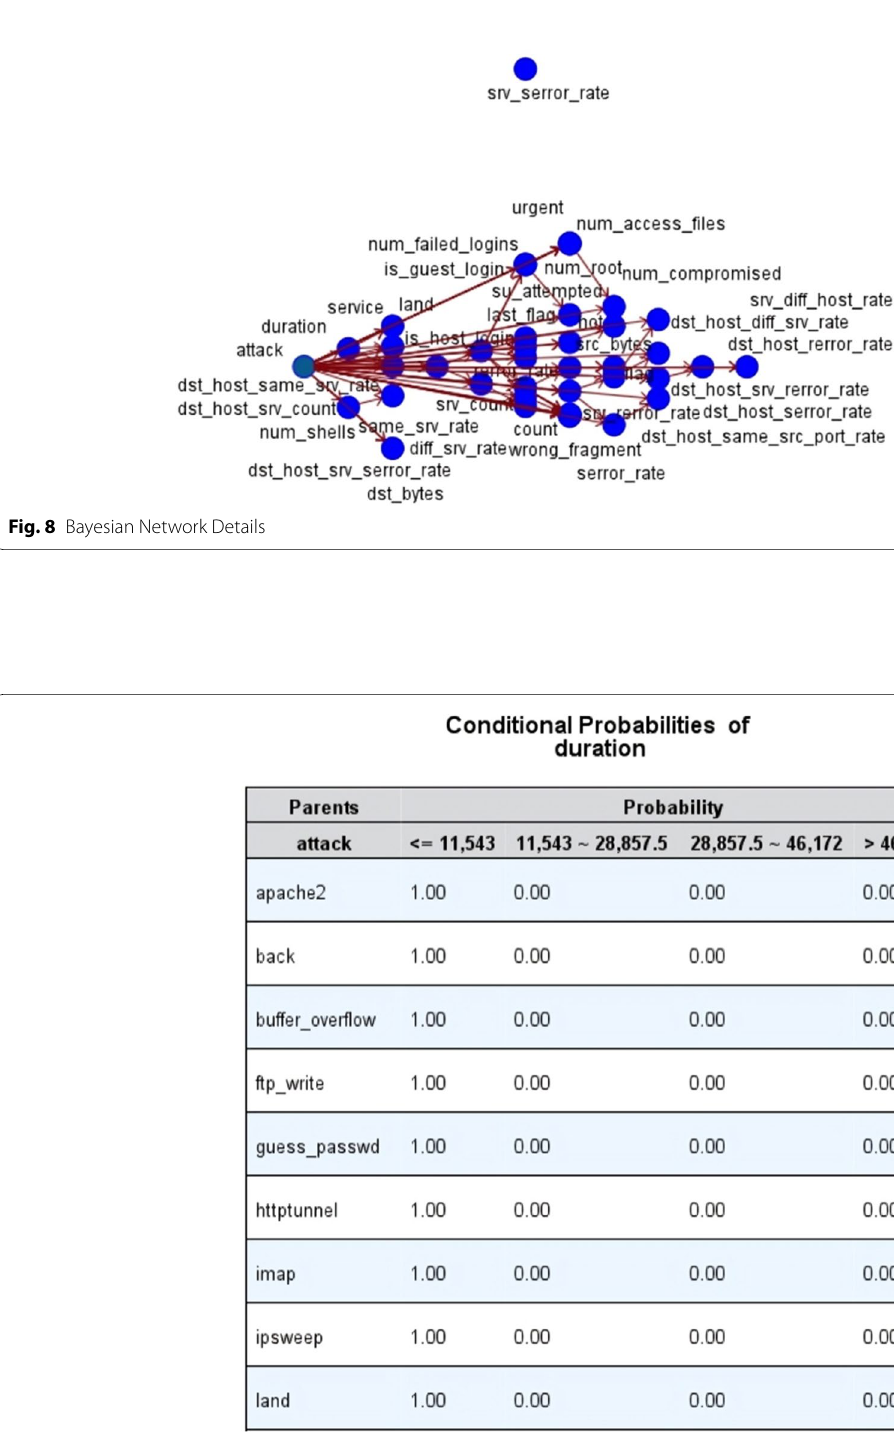
Fig. 9 Condition Probabilities for Bayesian